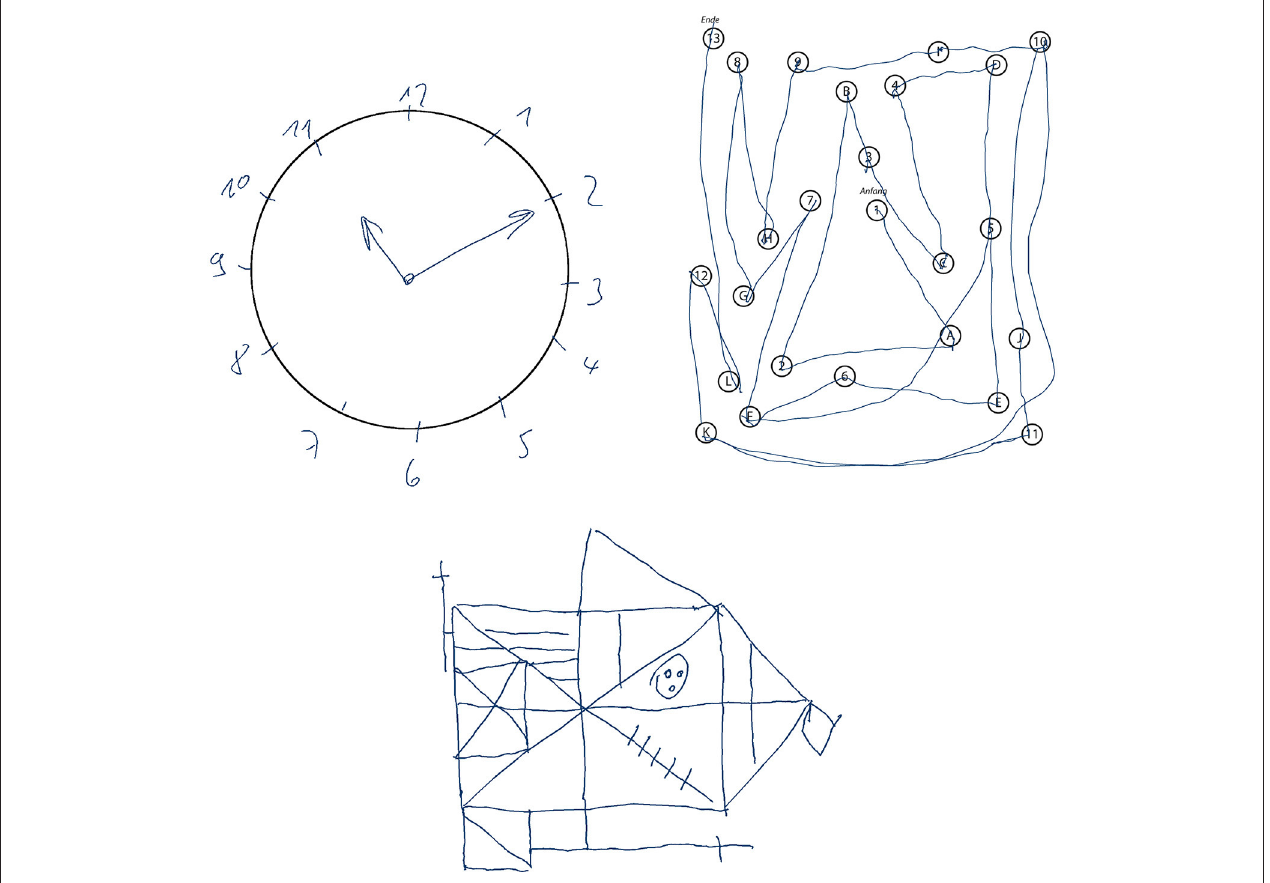
FIGURE 1 | Samples of cognitive assessments recorded during the Interakt project: Clock Drawing Test (upper left), Trail Making Test B (upper right), and Rey-Osterrieth Complex Figure Test